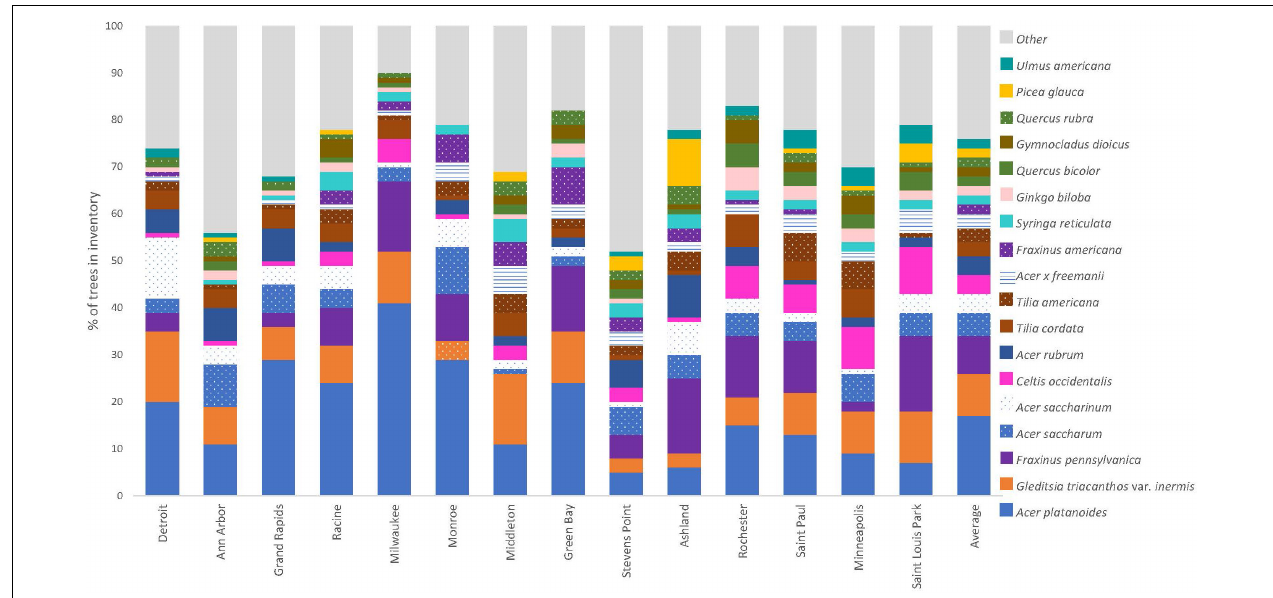
FIGURE 2 | Most common street trees (% of total) across the 14 municipal inventories. Species that accounted for an average of more than 1% across all municipalities are shown. Species within the same genus are indicated by different patterns within the same color. Municipalities are arranged left to right from southeast to